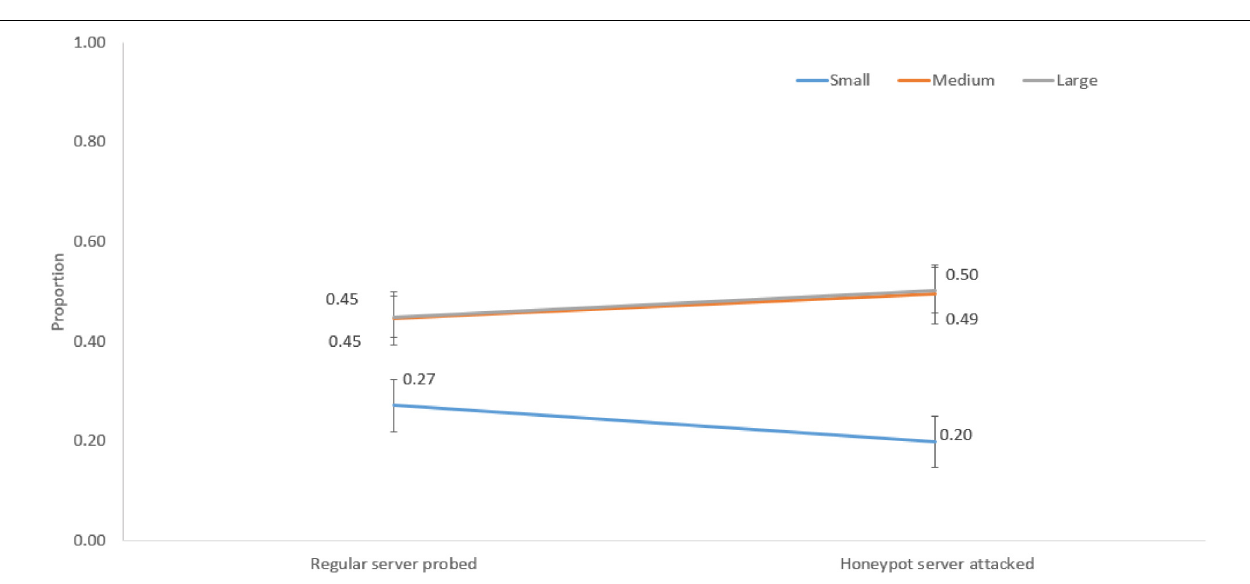
FIGURE 8 | The proportion of regular server probed and honeypot server attacked decisions in different network